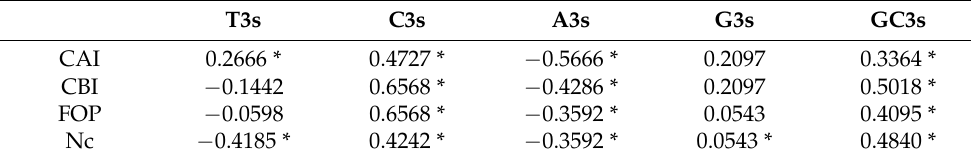
Table 3. Correlation analysis of codon usage indices in monocots.